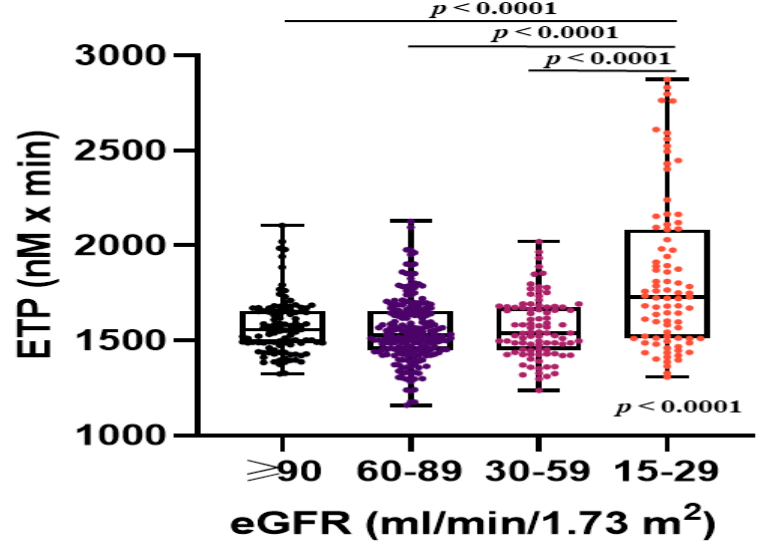
Figure 1. Associations between endogenous thrombin potential (ETP) and estimated glomerular filtration rate (eGFR) categories in patients with atrial fibrillation. Data are shown as medians (interquartile ranges) and maximum and minimum values.